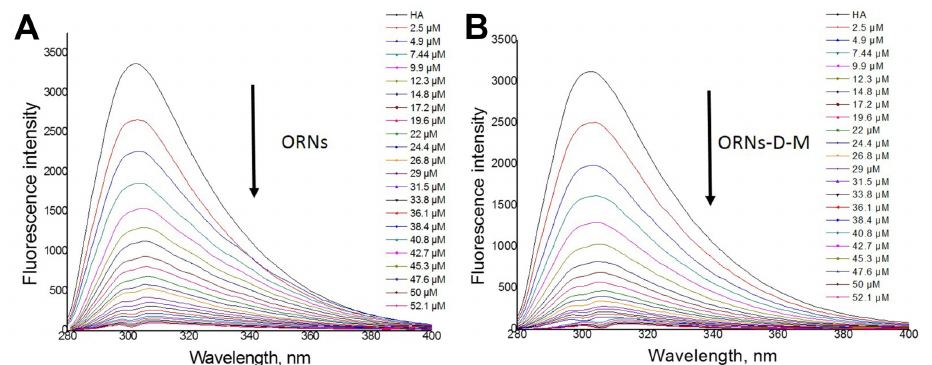
Figure 5. Quenching fluorescence of the hemagglutinin under titration with ORNs ( A ) and ORNs-D- M ( B )